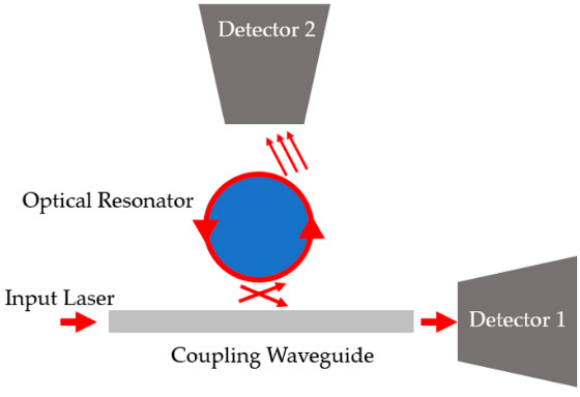
Figure 17. Example WGM resonator system. Reproduced from Open Access Article [107] in MDPI.